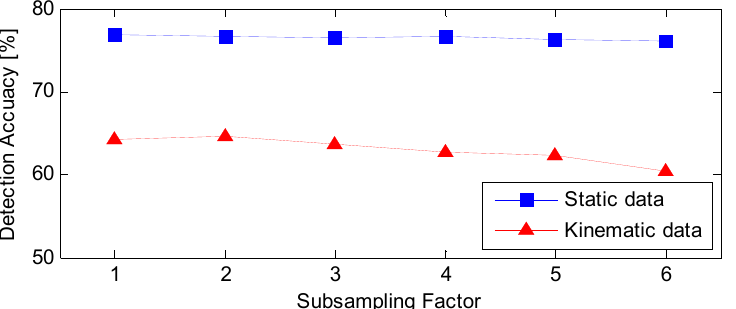
Figure 9. Detection results when changing the subsampling factor of the pooling layer with Dataset STU (blue squares) and KTU (red triangles).